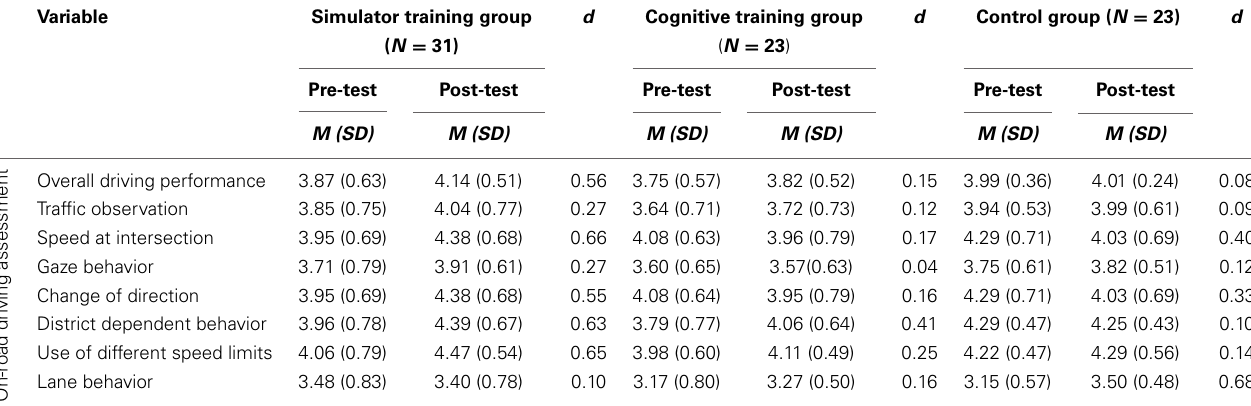
Table 7 | Descriptive statistics for on-road measures.